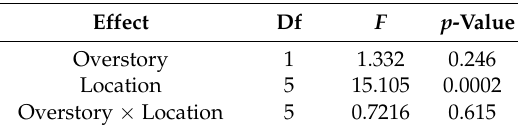
Table A1. PERMANOVA results for structural variables included in NMS ordination. Factor designations are as follows: Overstory, aggregate vs. intact forest; Harvest status, harvested vs. unharvested; overstory × harvest, interaction between the two main factors.